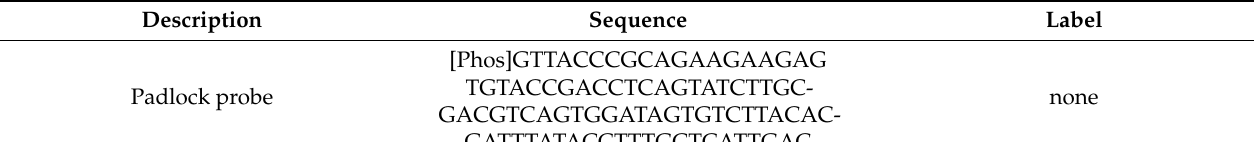
Table 1. Oligonucleotide sequences used in this